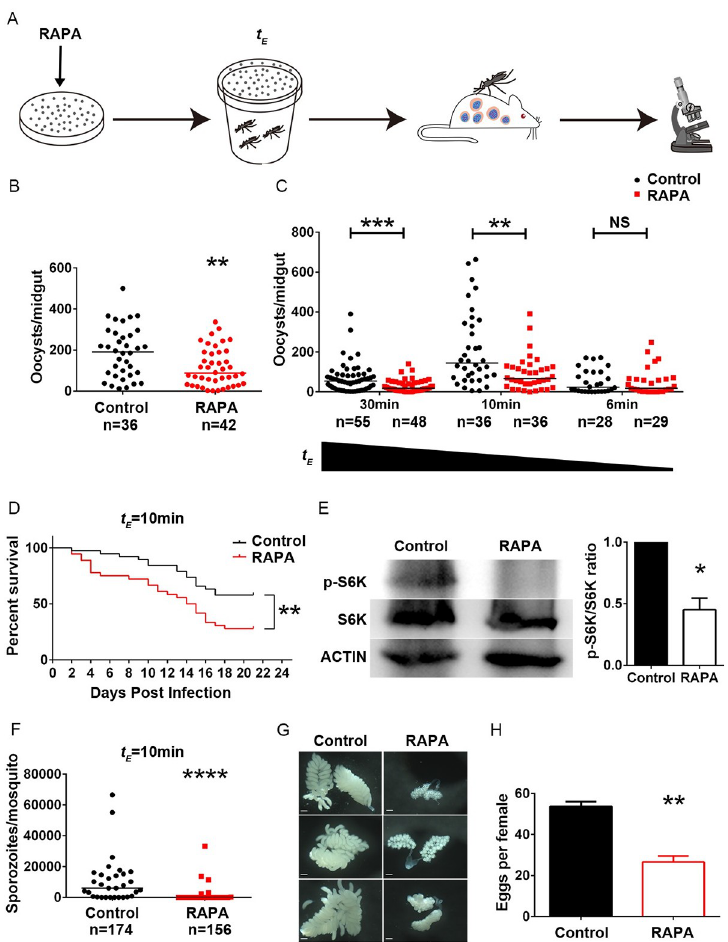
Fig 3. Exposing An . stephensi to a rapamycin-coated surface inhibits P . berghei infection, impairs survival and fecundity. (A) Schematic overview of exposing mosquitoes to a rapamycin-treated surface. A solvent-coated surface was used as a control. t E , exposure time. (B) Oocyst numbers in mosquitoes exposed to rapamycin (0.77 mmol/m 2 ) (red dots) or solvent (black dots) coated surfaces for 60 min. (C) Mosquitoes were exposed to a 0.77 mmol/m 2 rapamycin-coated Petri dish for 30 min, 10 min, and 6 min. Data were pooled from two independent replicates (B, C). (D - H) Mosquitoes were incubated with a 0.77 mmol/m 2 rapamycin- or solvent-coated surface for 10 min. (D) Survival curve of mosquitoes exposed to rapamycin (n = 38) or solvent (n = 36) coated surfaces. (E) Western blot analysis of S6K phosphorylation in fat bodies collected from rapamycin-exposed mosquitoes and controls. The bar chart represents relative quantification of signal intensity of p-S6K from two independent replicates as determined by ImageJ software. Error bars indicate standard errors. (F) Sporozoite numbers of rapamycin-treated mosquitoes (red dots) and controls (black dots). Data were pooled from two independent replicates. (G) Ovaries were dissected at 48 h post-normal blood meal from rapamycin-exposed and control mosquitoes. Scale bar, 200 μ m. (H) Mean number of eggs laid by 25–35 gravid rapamycin-exposed and control mosquitoes. Data were pooled from three independent replicates. Results from one of three independent experiments are shown (D, G). Horizontal black bars indicate the median values. Significance was determined by Mann-Whitney tests in (B), (C), and (F), by a Log-rank (Mantel-Cox) test in (D), and by Student’s t -test in (E) and (H); � P < 0.05, �� P < 0.01, ��� P < 0.001, ���� P < 0.0001. hypothesis, we first exposed An . stephensi to Petri dishes coated with different concentrations of rapamycin 60 min before infection (Fig 3A). Surprisingly, exposing mosquitoes to rapamy- cin at 3.85 mmol/m 2 and 0.77mmol/m 2 led to a rapid increase of mortality in fully engorged An . stephensi in comparison to the controls. The surviving mosquitoes displayed increased resistance to P . berghei infection compared to controls (Figs 3B and S3A). A low concentration of rapamycin (0.077 mmol/m 2 ) had no effect on parasite infection (S3B Fig). We next